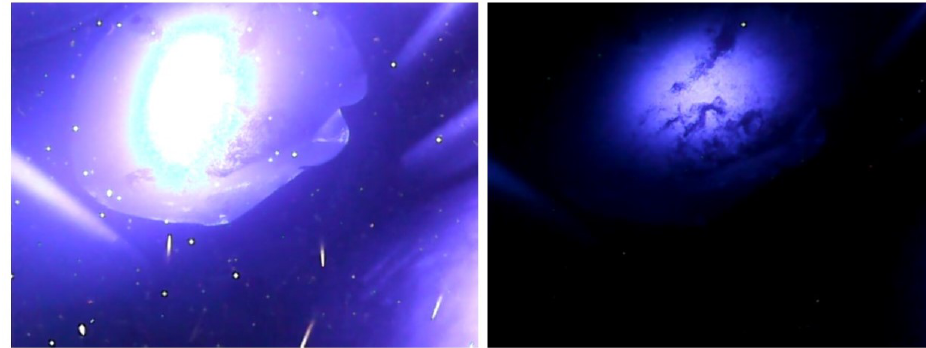
Figure 5. 2D images taken by the π 3 detector with beam currents of 360 nA ( left ) and 60 nA ( right